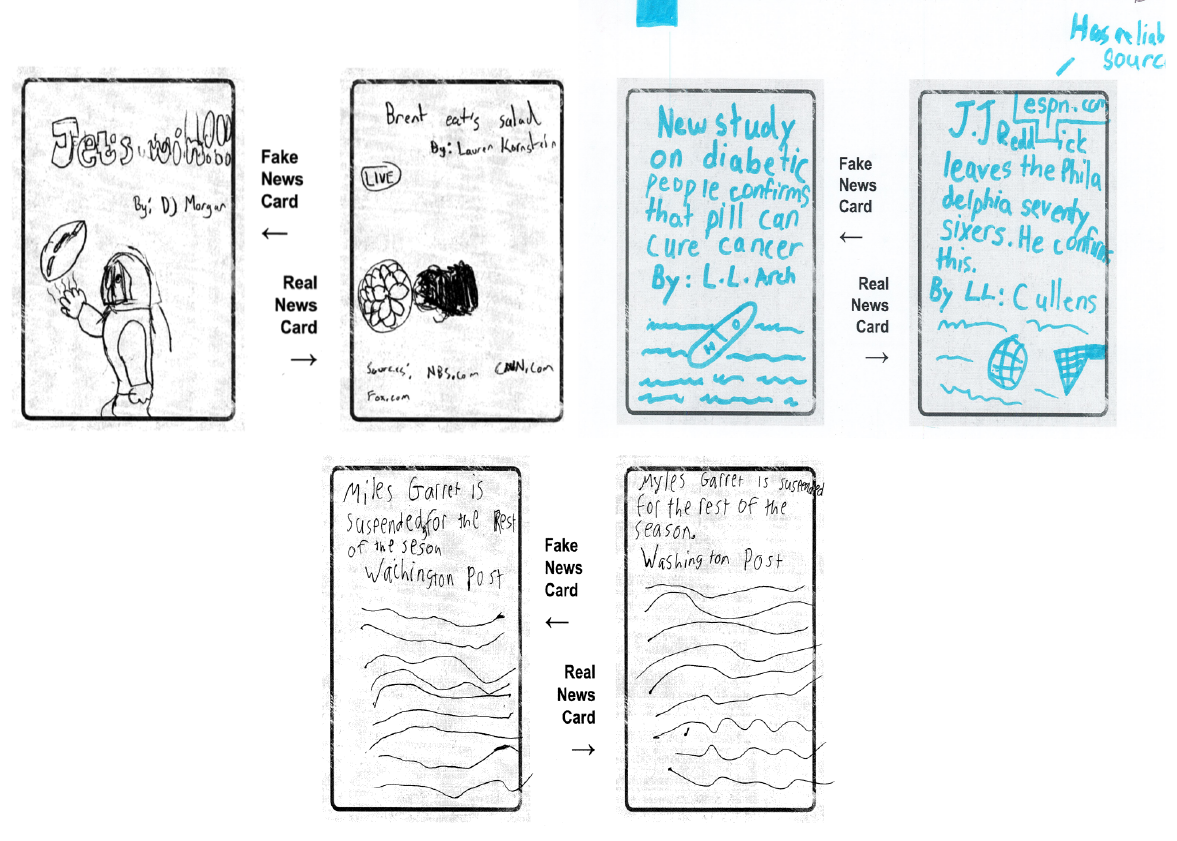
Figure 1. In the post-game activity where students created their own real and fake news cards, some students applied the news literacy skills to their own interests (here,